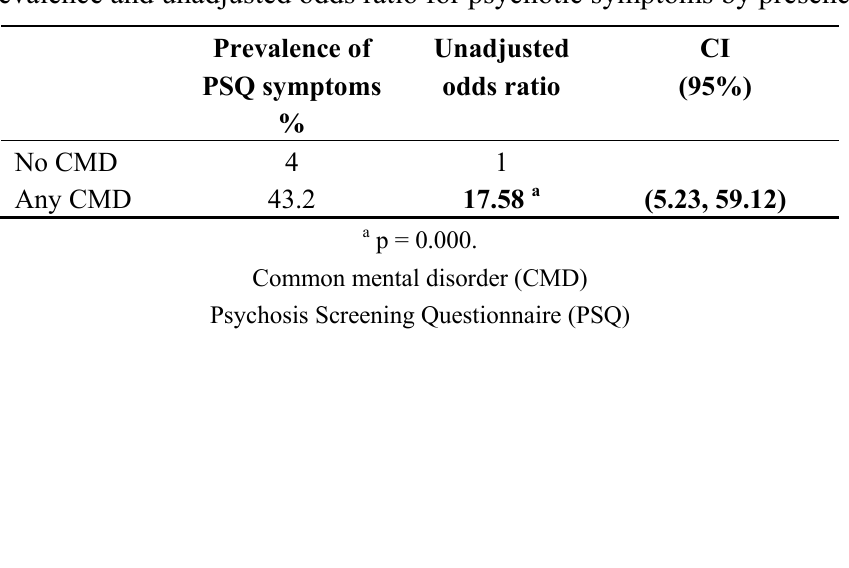
Table 2. Prevalence and unadjusted odds ratio for psychotic symptoms by presence of